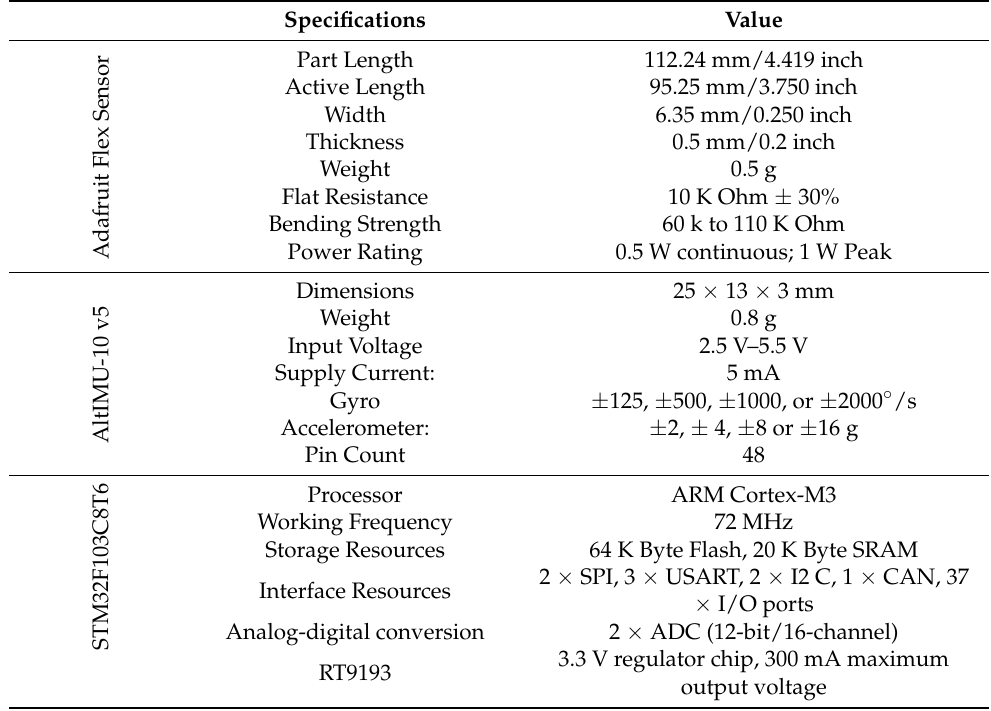
Table 4. Flex sensor, IMU sensor, STM32 card